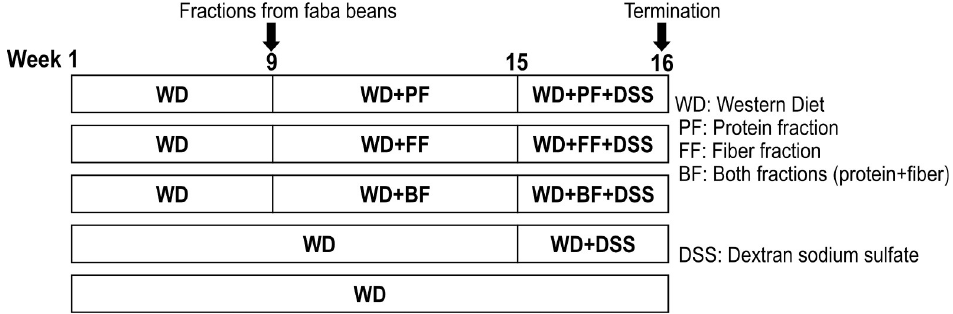
Fig 1. Timeline of feeding trial prior and during 1% DSS treatment. For eight weeks, all C57BL/6JRj mice (n = 60) were fed a WD. From week 9 mice (n = 12) were divided into four dietary groups, in which faba bean fractions were introduced in the WD: 1) WD incorporated with 30% faba-bean protein fraction (WD+PF), 2) WD with 7% fiber fraction (WD+FF), 3) WD with both protein and fiber fraction (WD+BF) or 4) WD without faba bean content (n = 24). The mice were followed for another eight weeks. The last six days before experiment termination, mice were exposed to 1% DSS in the drinking water expect half of the WD only group (n = 12), serving as negative controls for the DSS